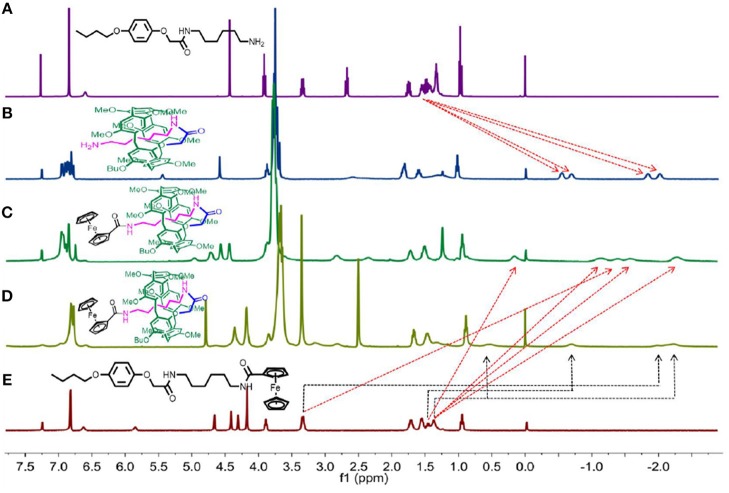
1H NMR spectra (400 MHz, 298K) of: (A) AM3 in CDCl3; (B) P[5]4PR in CDCl3; (C) P[5]4R in CDCl3; (D) P[5]4R in DMSO-d6; (E) M3 in CDCl3.